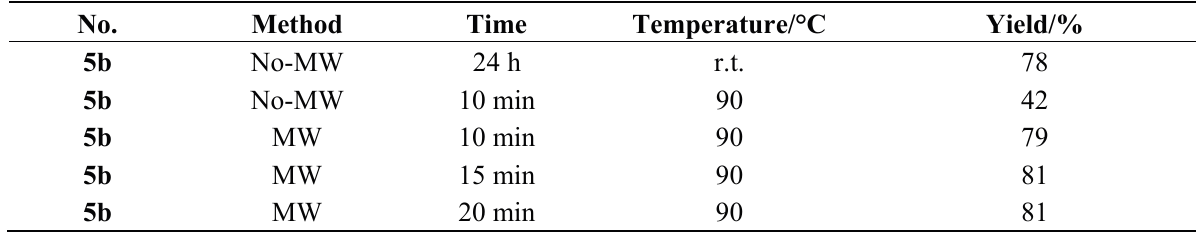
Table 1. Comparison of yields of 5b through methods with or without microwave